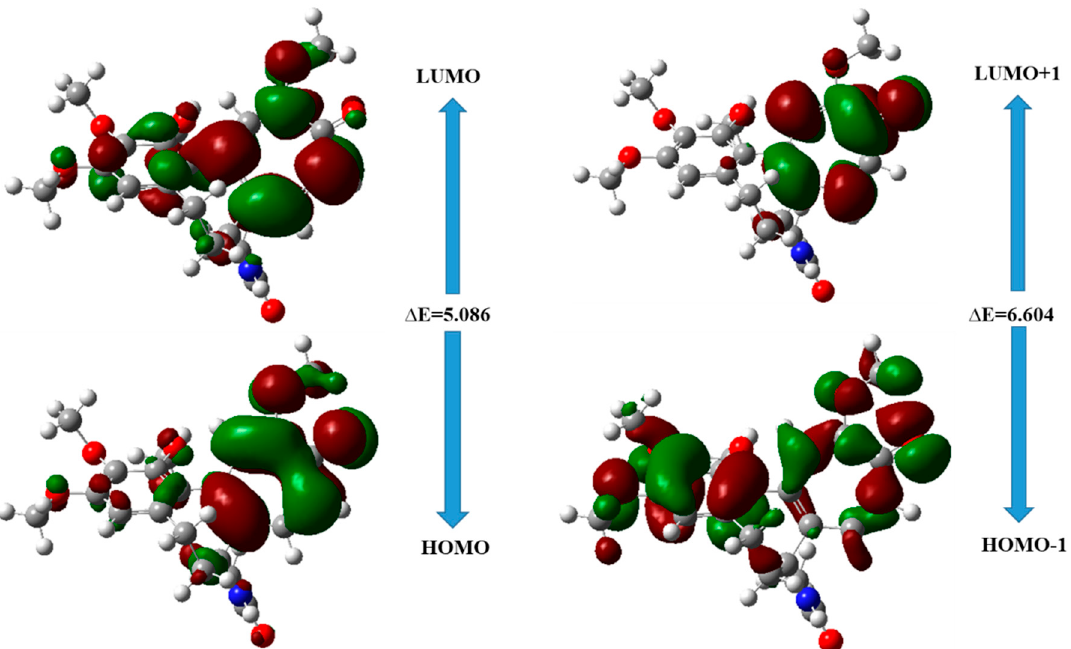
Figure 8. Frontier molecular orbitals of compound 1